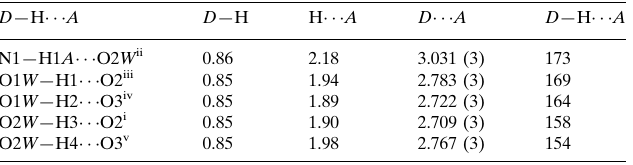
Hydrogen-bond geometry (A˚ , (cid:2)